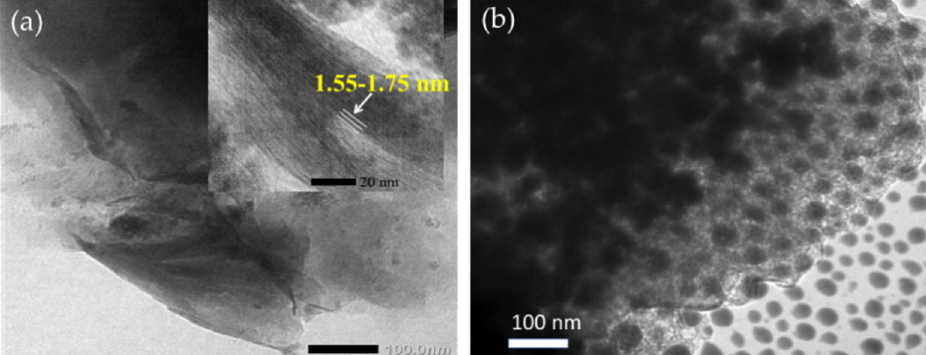
Figure 8. TEM images of SnO 2 /montmorillonite at Sn/montmorillonite ratios of ( a ) 2.5 and ( b ) 10.0 mmol/10 g. Adapted from Ref. [80] with permission from the Elsevier B.V., 2021.